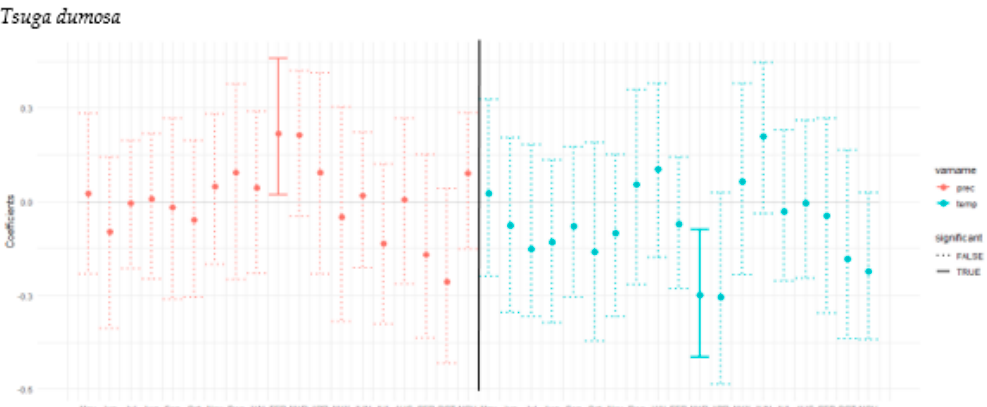
Figure 4. Bootstrapped correlation function analysis of tree ring growth of Abies pindrow , Pinus wallichi- ana , and Tsuga dumosa to sums of precipitation and mean monthly temperature from previous May to current November for Jiri, Nepal. Months from the previous years are denoted with lowercase letters, while months in the current year are denoted with uppercase